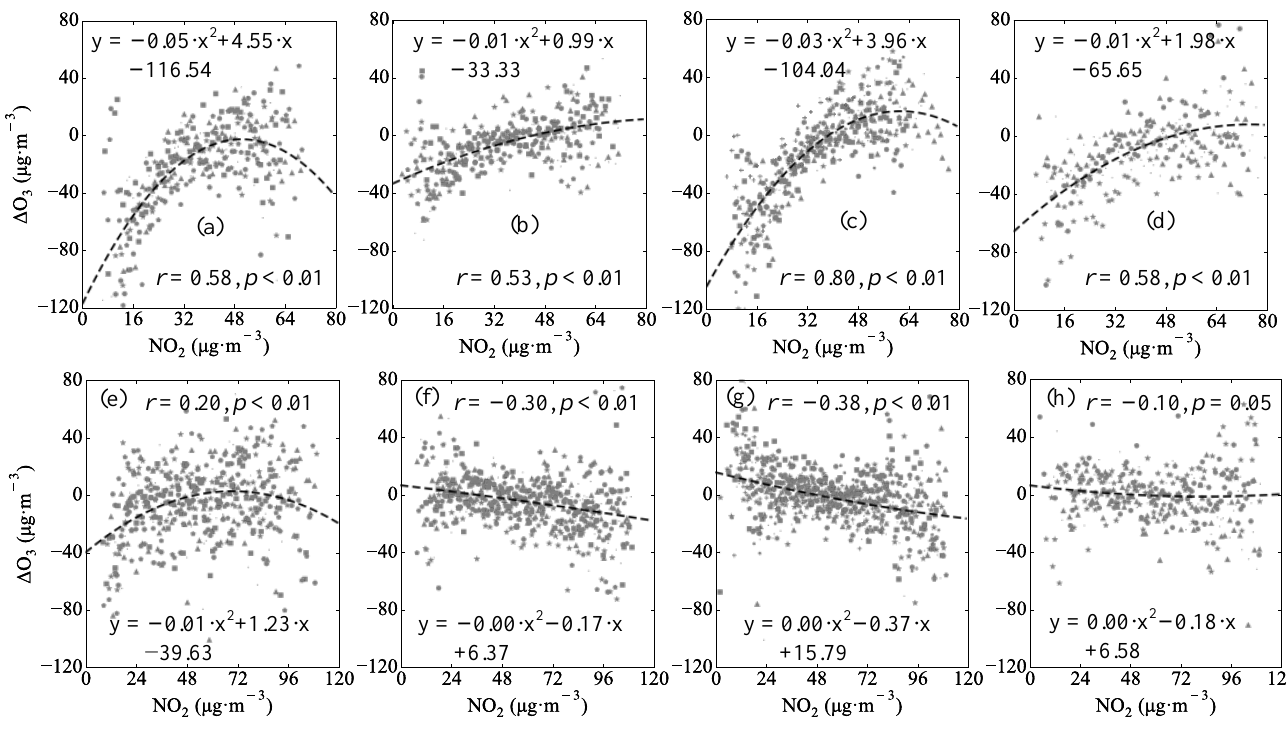
Figure 5. Data pairs of ∆ O 3 and NO 2 concentration during ( a – d ) April–September and ( e – h ) October–